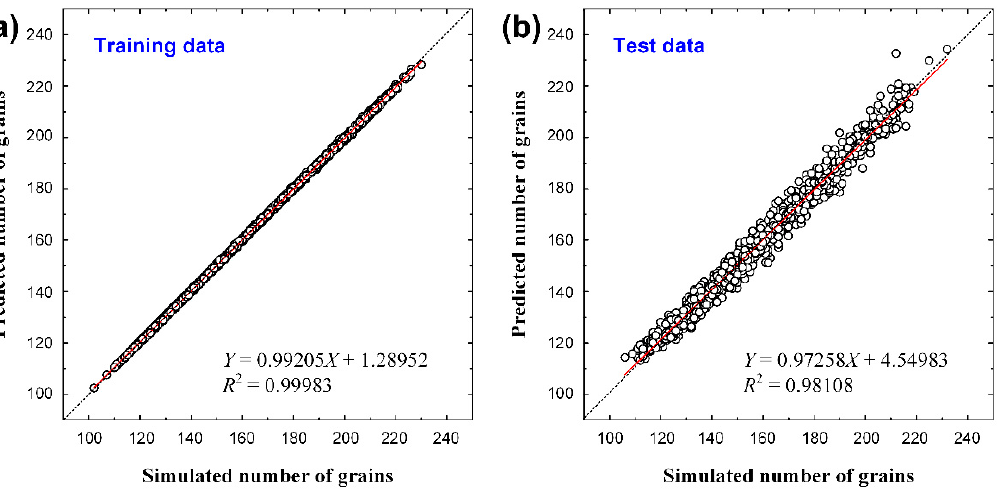
Figure 6. Comparison between the measured and predicted numbers of grains for ( a ) 3000 training data and ( b ) 1000 test data. X and Y axes represent measured and predicted values, respectively.